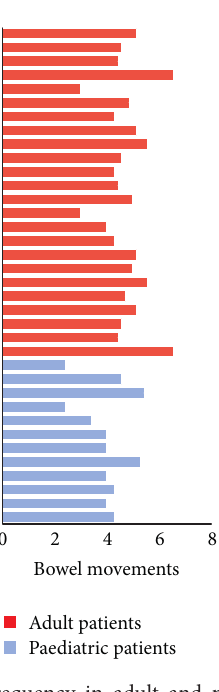
Figure 1: Stool frequency in adult and paediatric patients with IPAA. Bars represent the mean scores of a 7-day diary. Most patients reported four to six bowel movements daily. No significant differences were observed relative to age at surgery [paediatric versus adult IPAA, median (range): 5 (1–9) versus 5 (2–9), 𝑃 = 0.54